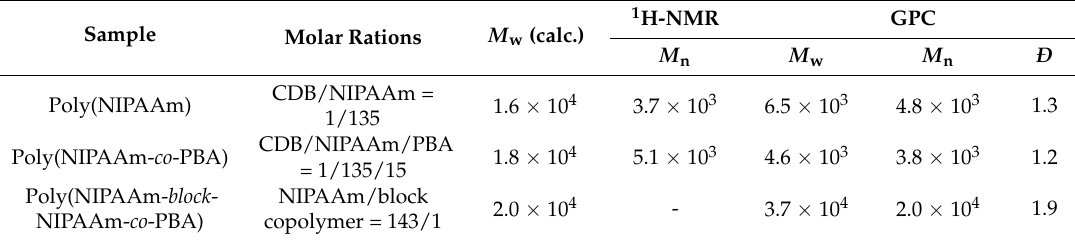
Table 1. The results of gel permeation chromatography (GPC) and 1 H-NMR analyses of poly(NIPAAm), poly(NIPAAm- co -PBA), and the diblock copolymer, molar ratios in RAFT polymerization, and theoretical molecular weight